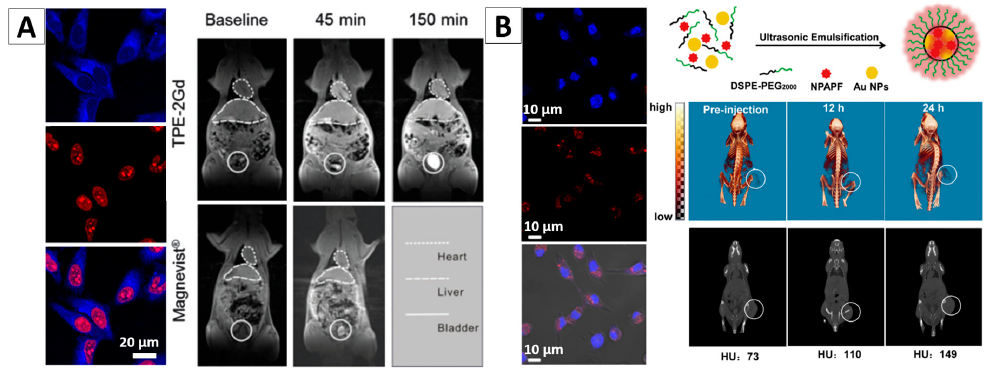
Figure 6. ( A ) Cell imaging and in vivo MIR imaging with TPE-2Gd NPs [78]; ( B ) Molecular structures of co-encapsulation of NPAPF and Au by DSPE-PEG2000 and their application in fluorescent cell imaging and in vivo CT imaging [65]. Reprinted with permission from [65,78], respectively. Copyright 2016 Elsevier and Copyright 2014 American Chemical Society, respectively.